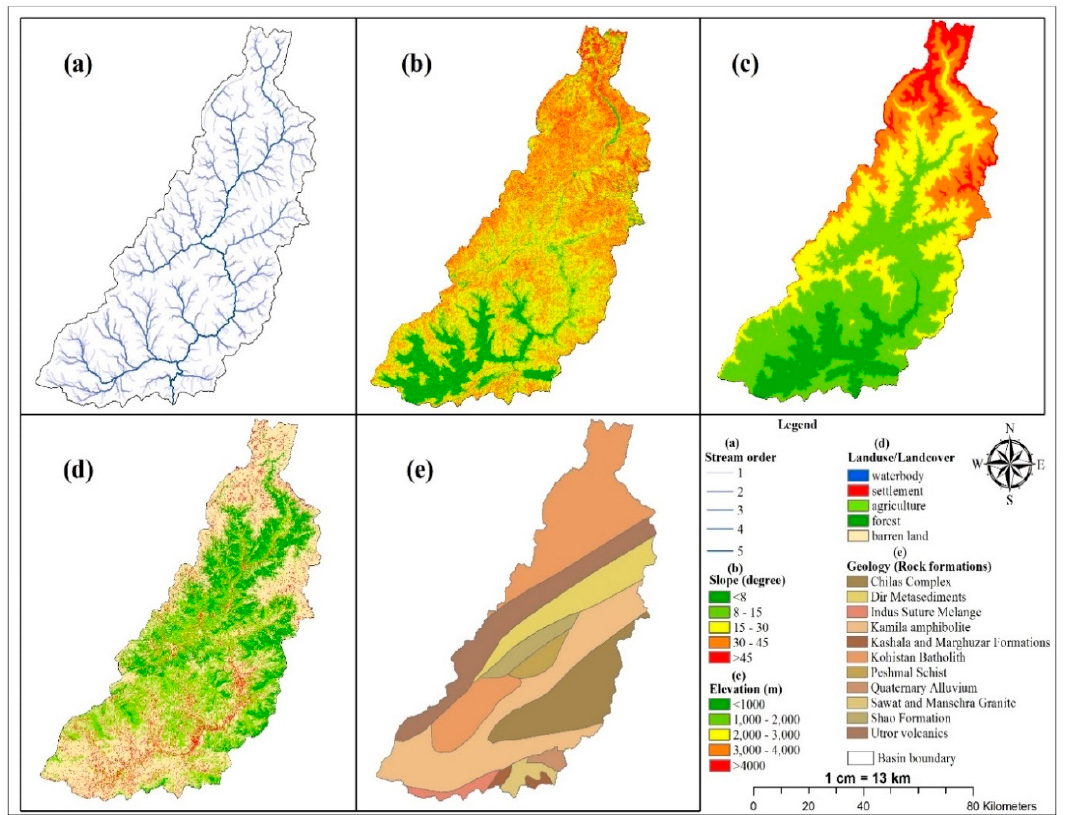
Figure 3. Essential parameters: ( a ) stream order ( b ) slope ( c ) elevation ( d ) land use and land cover (LULC) ( e ) geology.